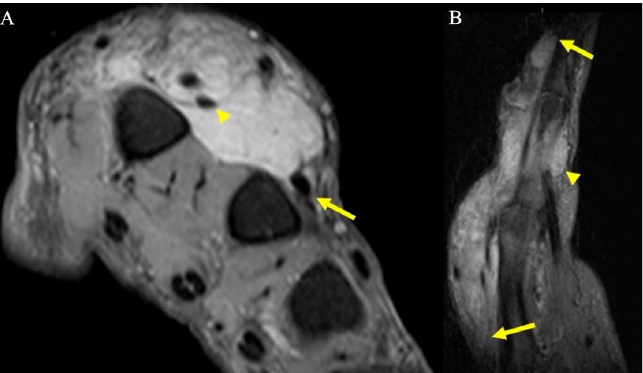
Figure 14. A 67 ‐ year ‐ old man with soft tissue mass of the hand. ( A ) Axial fat ‐ suppressed PD MRI shows a large hyperintense soft ‐ tissue mass in the dorsum of the hand, centered over the second and third metacarpals, and encasing the index finger extensor tendons (arrowhead), and thin tails of infiltrating tumor partially encasing middle finger extensor tendon (arrow). ( B ) Sagittal fat ‐ sup ‐ pressed PD MRI highlights the extent of the infiltrative mass along the index finger dorsally (ar ‐ rows), as well as smaller volar components (arrowhead). Initially, this was thought to be an abscess but was later revealed to be acral myxoinflammatory fibroblastic sarcoma after incisional biopsy, and ultimately required second and third ray amputations to achieve wide negative margins.